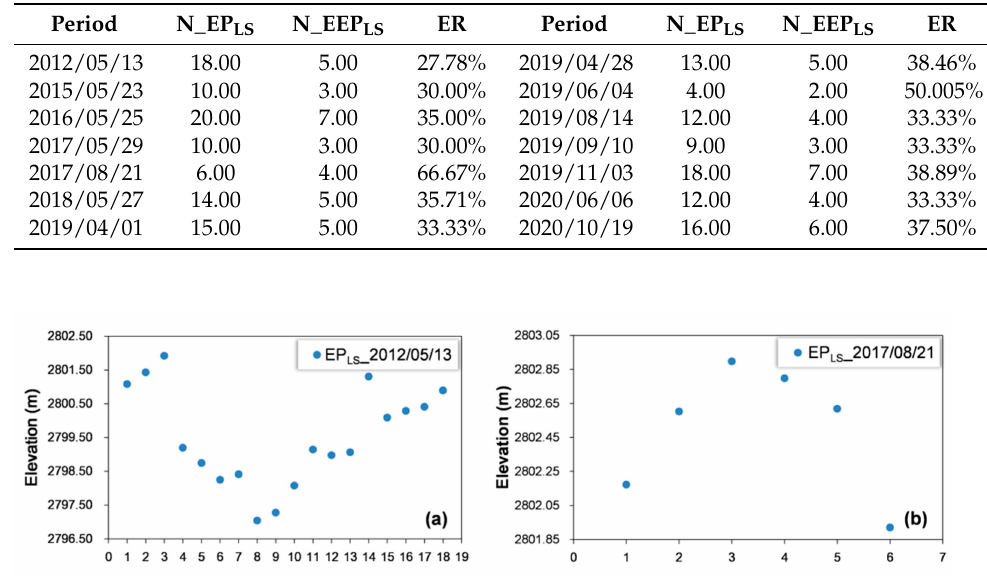
Figure 8. Distribution of elevation points on the lake surface on ( a ) 13 May 2012 and ( b ) 21 August